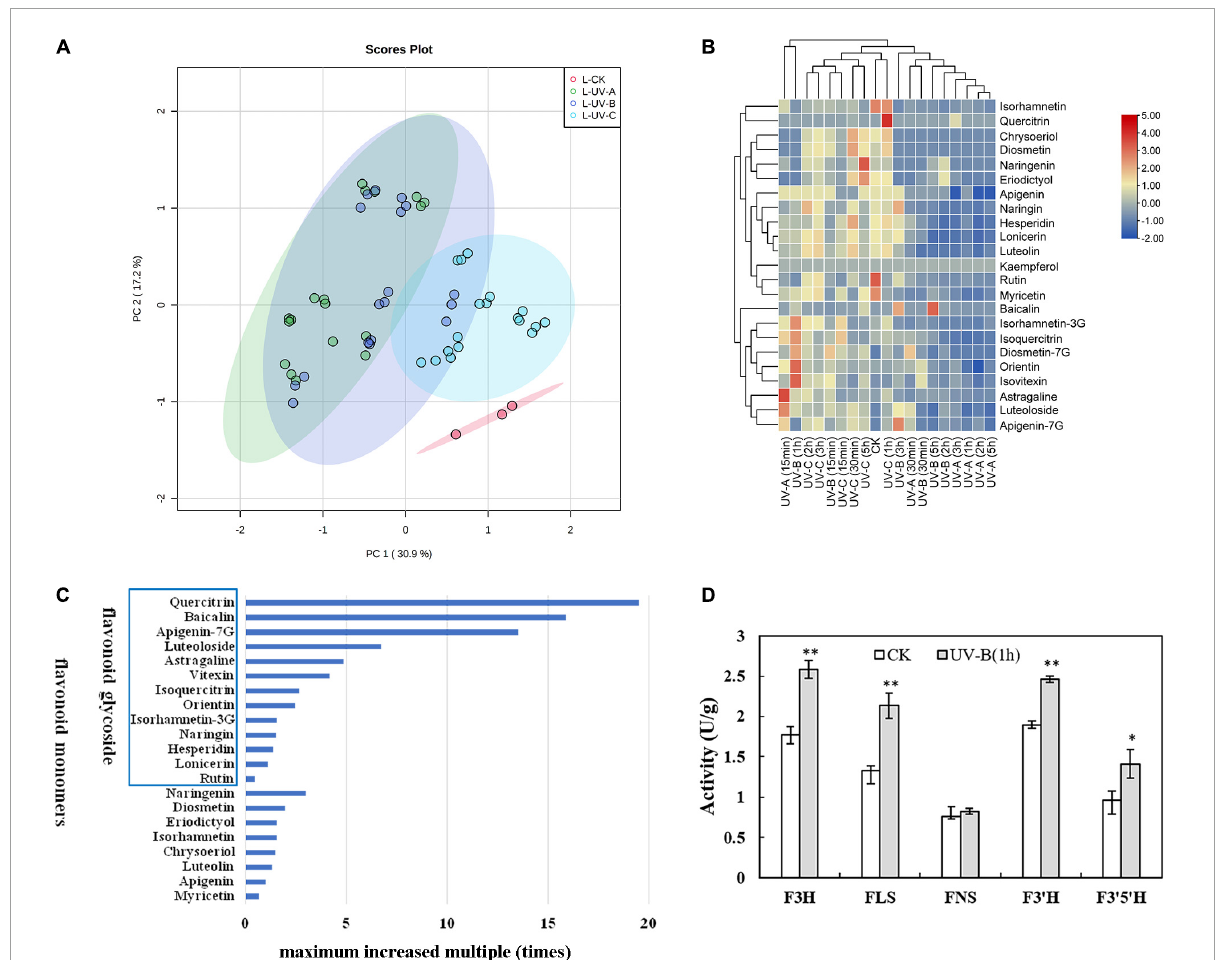
FIGURE3 Flavonoid metabolites in leaves of Tetrastigma hemsleyanum with UV treatments. (A) PCA score plot of metabolites in leaves. (B) Heatmap of flavonoid metabolites in leaves. (C) The maximum increased multiple of flavonoid monomers with different structural characteristics in leaves. (D) Activities of flavanone 3-hydroxylase (F3H), flavonol synthase (FLS), flavone synthase (FNS), flavonoid-3 (cid:48) -hydroxylase (F3 (cid:48) H), flavonoid-3 (cid:48) ,5 (cid:48) -hydroxylase (F3 (cid:48) 5 (cid:48) H) enzyme with UV-B 1 h treatment in leaves. * P < 0.05, ** P <